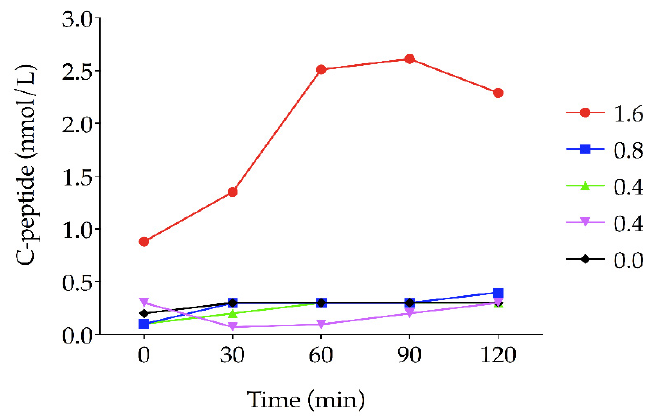
Figure 2. Area under the curve (AUC-CP) for mixed-meal tolerance test (MMTT)-stimulated C-peptide in five patients at three years after completion of the trial.